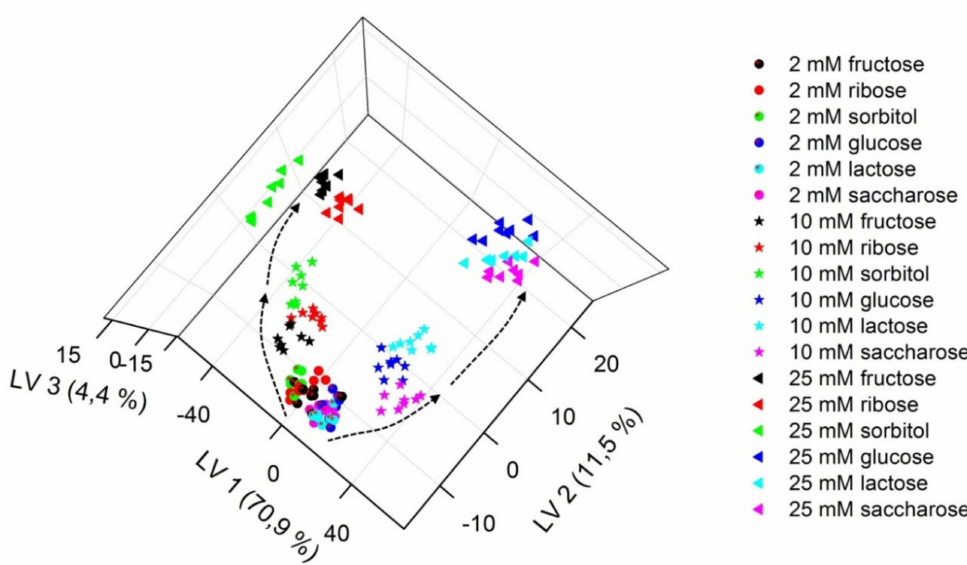
Figure 5. Partial least squares-discriminant analysis (PLS-DA) plot of chemical images of samples containing studied receptors, Alizarin Red S (ARS), and selected saccharides (at three various concentration levels).